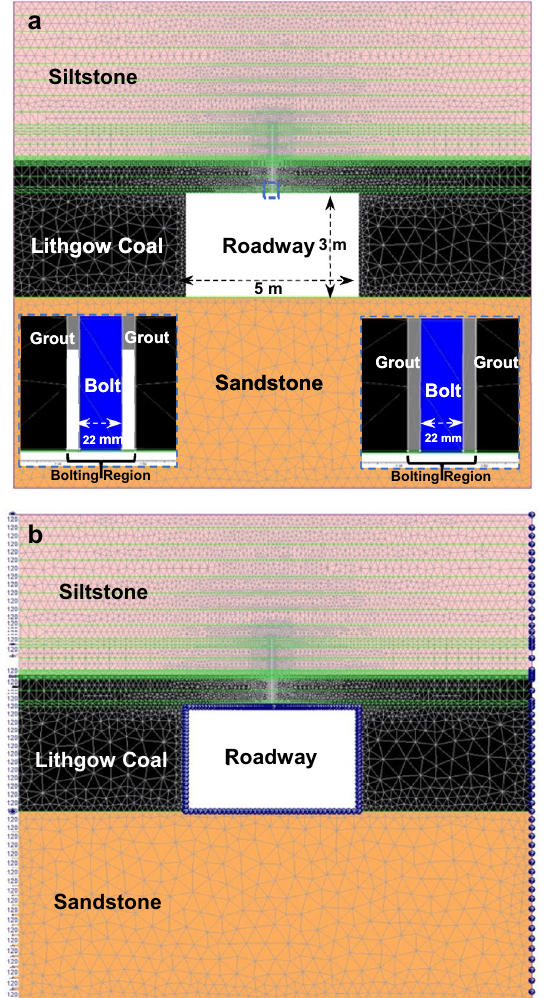
Fig. 2 A model layout used in this study designed using RS 2 . a inset left and right is an example of a partially grouted and fully grouted bolt, respectively, b model layout demonstrating hydraulic boundary conditions. Note left hand boundary of 120 m hydraulic